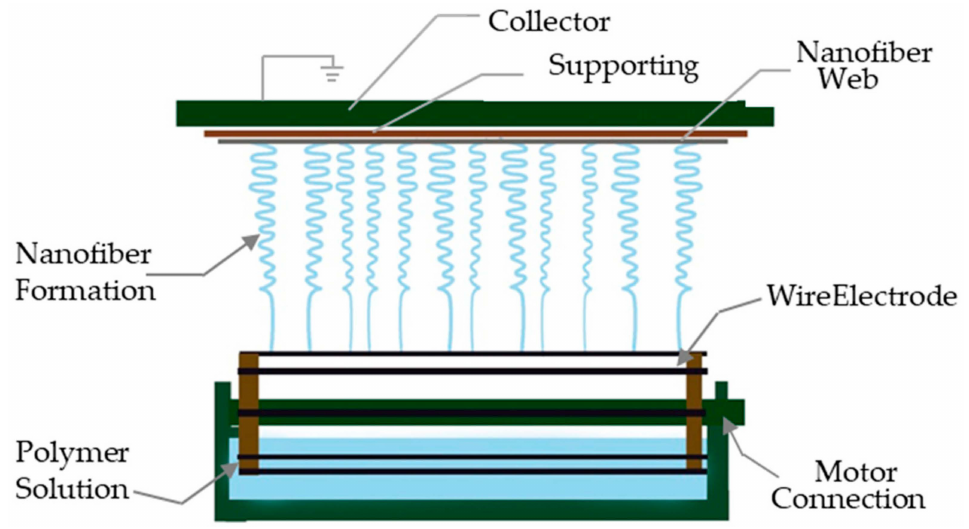
Figure 12. A basic representation of the linear needle-less electrospinning setup